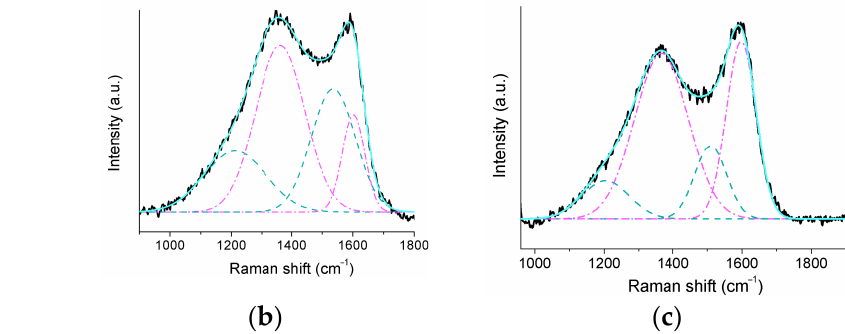
Figure 5. Raman spectra of ( a ) N-CNTs, ( b ) N-CNPs, and ( c ) the LFP/C PANI -II. The dotted lines show the spectral curve fitting.